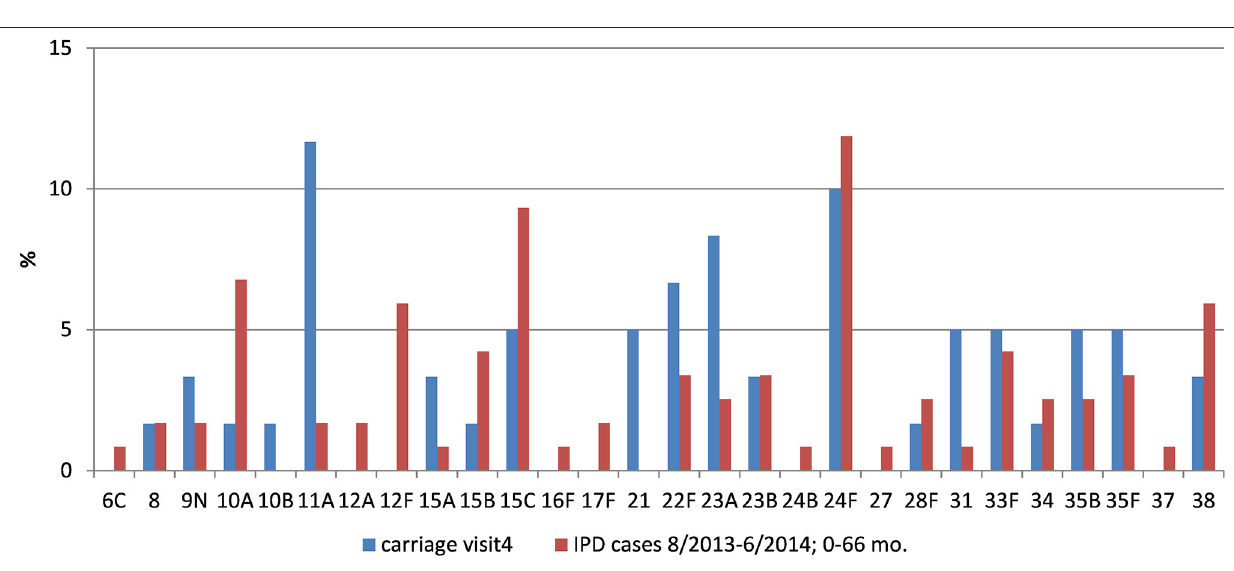
FIGURE 5 | Pneumococcal non-vaccine-type carriage in our study population and IPD data from comparable age